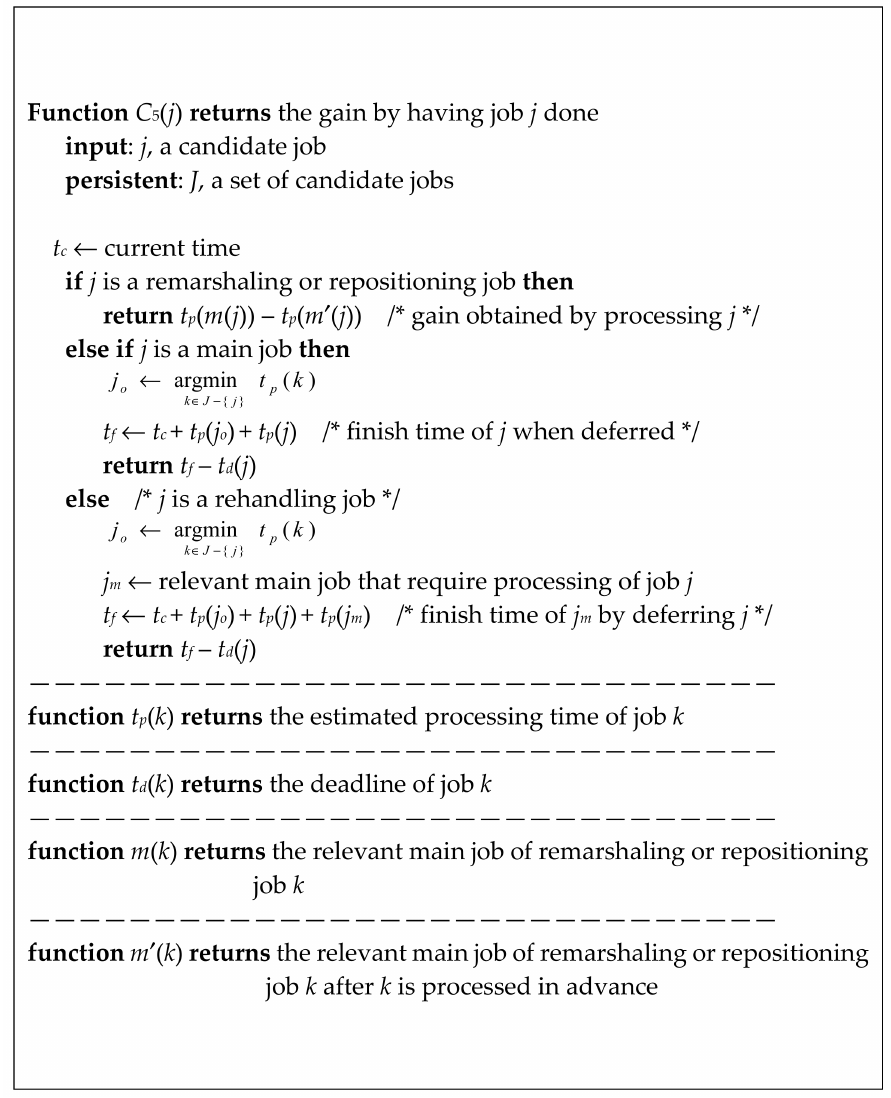
Figure 5. Pseudocode for evaluating the criterion C 5